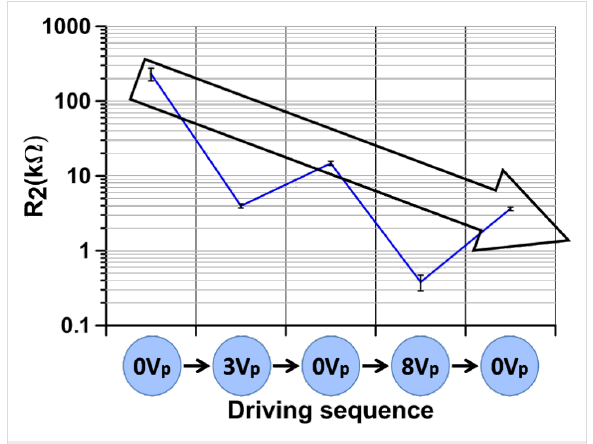
Figure 6: R 2 average evolution with the driving sequence. The three unbiased averaged measurements are shown inside the